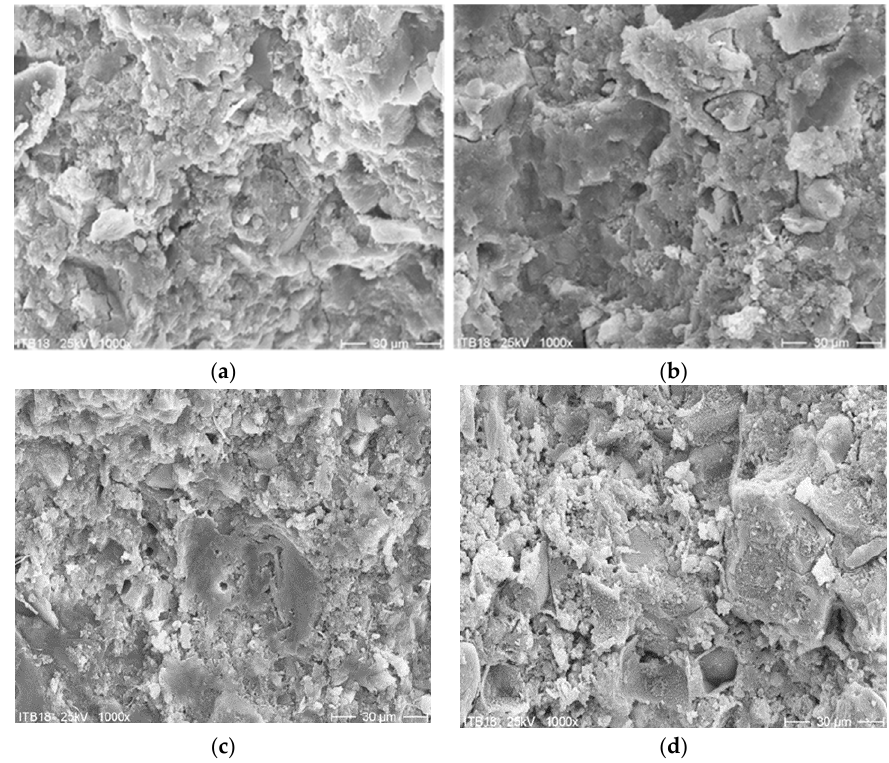
Figure 5. SEM image of fracture of PCC mortar I sample cured at 21 ◦ C (( a )–after two days of curing, ( b )–after 28 days of curing) and 8 ◦ C (( c )–after two days of curing, ( d )–after 28 days of curing); 1000 × magnification).